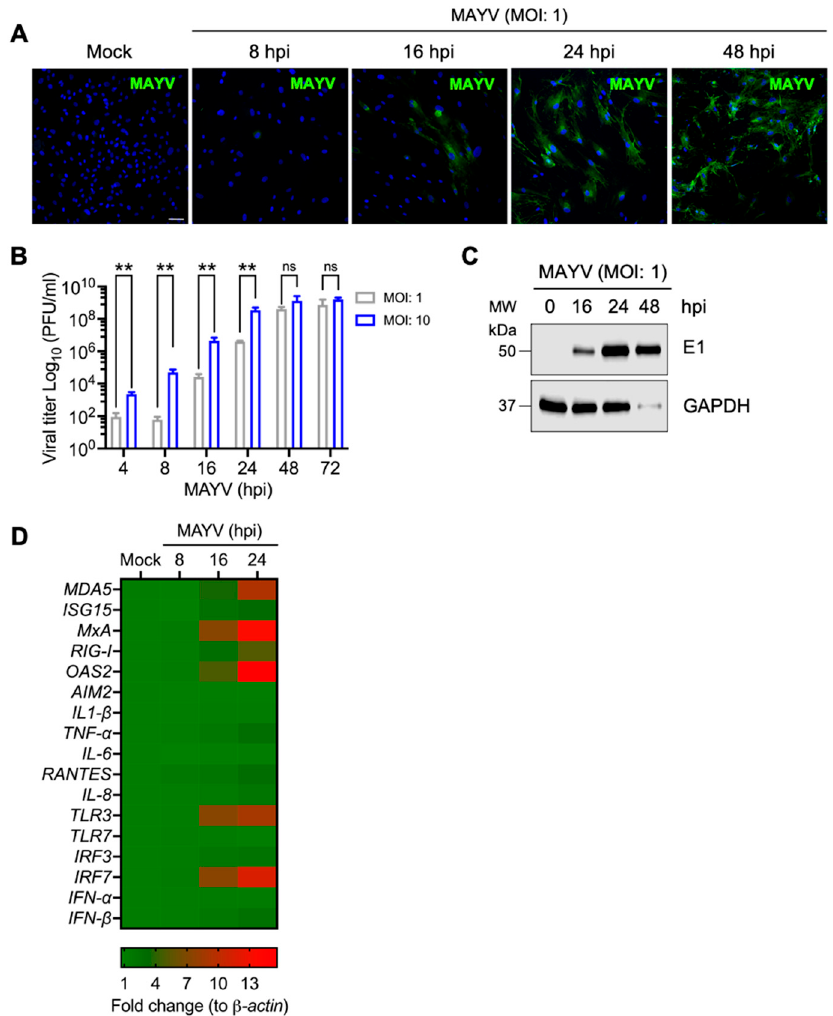
Figure 1. Primary human dermal fibroblasts are susceptible to MAYV infection. ( A ) HDFs grown on glass coverslips were infected with MAYV at an MOI of 1; at different time points, the cells were stained with an anti-MAYV mouse primary antibody, followed by an Alexa-Flour 488 mouse secondary antibody. Cell nuclei were stained with Dapi. Images were captured with a confocal microscope and analyzed with ImageJ software. Scale bar, 50 µm. ( B ) HDFs were infected with MAYV at the indicated MOI, and viral progeny production in cell supernatants collected at different time intervals was measured using plaque assay. Viral titers are represented as plaque-forming units per milliliter (PFU/mL). Statistically significant differences were evaluated with the Mann–Whitney test: ** p < 0.01; ns: non-significant. ( C ) The levels of viral E1 protein at different time points were determined in cell lysates from mock- or MAYV-infected HDFs using immunoblot. GAPDH protein was used as a loading control. MW: molecular weight. kDa: kilodaltons. ( D ) Heat map showing the expression profile of specific interferon-stimulated genes, inflammatory cytokines, chemokines, and transcription factor genes implicated in the immune response in mock- or MAYV-infected HDFs using quantitative